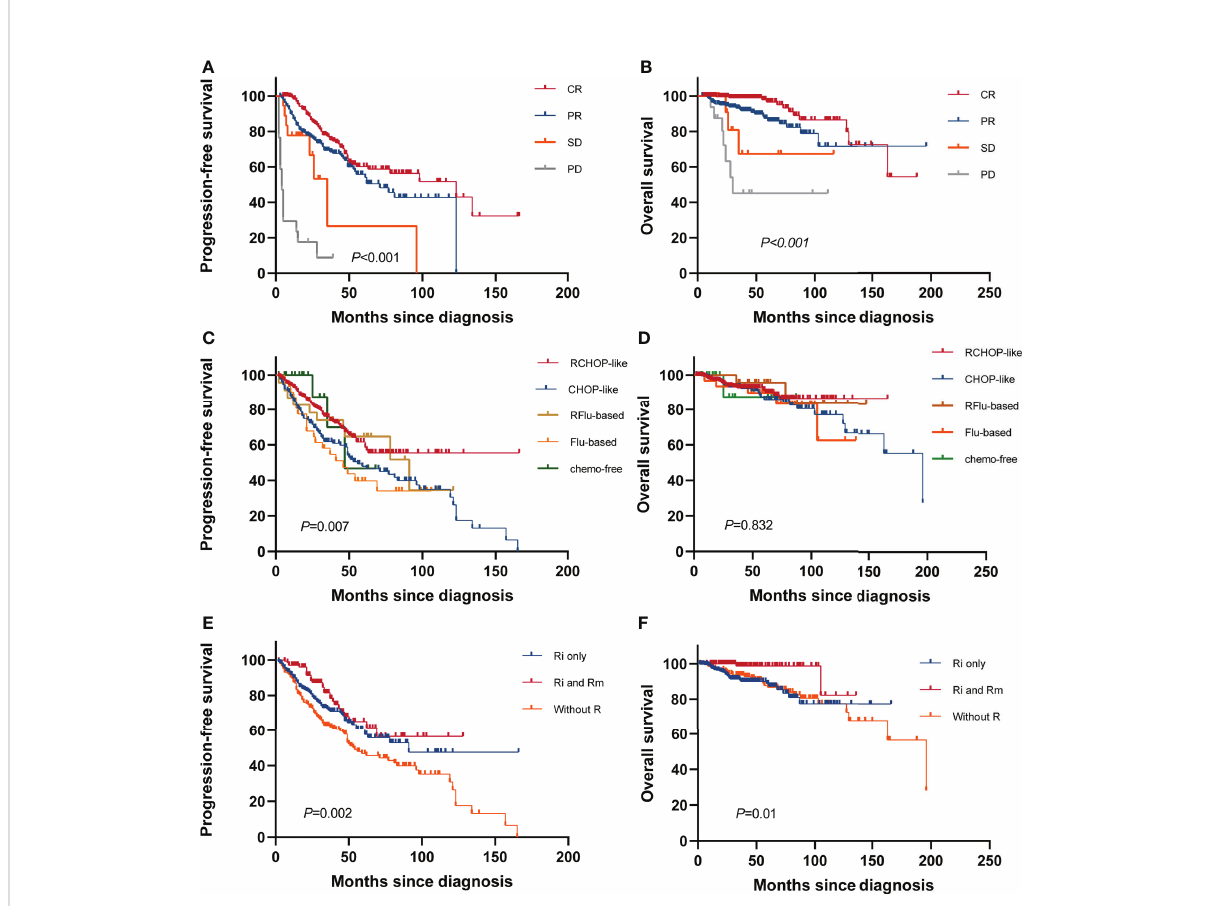
FIGURE 3 Survival based on treatment. Kaplan – Meier curves of (A) PFS and (B) OS based on remission status at the end of fi rst-line therapy. (C) PFS and (D) OS for all systemic therapy regimens. (E) PFS and (F) OS according to different rituximab administrations [no rituximab treatments (without R), fi rst-line induction chemotherapies with rituximab (Ri only), followed by rituximab maintenance (Ri and